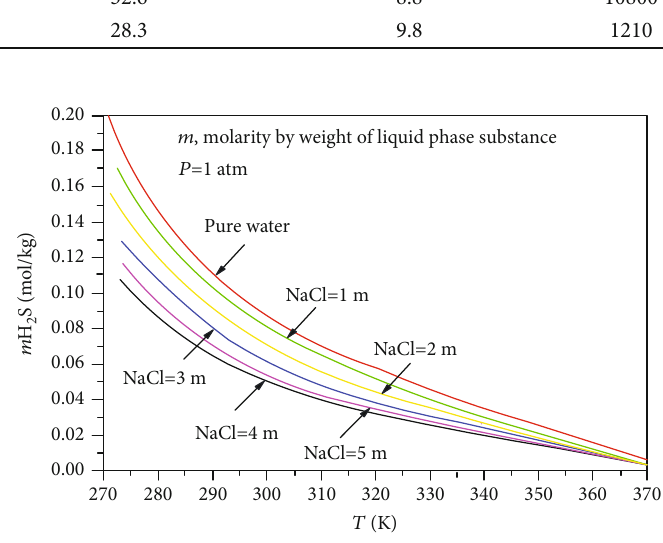
Figure 8: Solubility of H